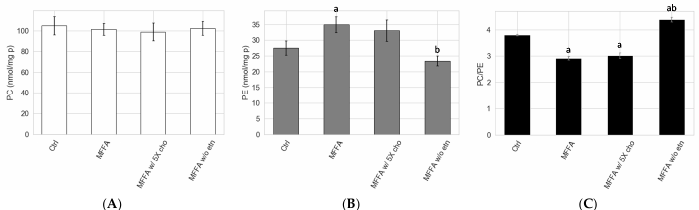
Figure 6. Impacts of altered supplies of key nutrients involved in phospholipid biosynthesis on MFFA-treated hepatocyte phospholipid and PC/PE. Isolated rat hepatocytes were treated without (Ctrl) or with 2 mM of MFFA in special DMEM media of which choline was increased to five times of the standard doses (i.e., 150 μM, MFFA w/5X cho), or had ethano- lamine removed completely (MFFA w/o etn) for 24 h before being harvested and lipid extraction. The cellular PC and PE profiles were subsequently determined by LC-MS lipidomic analysis ( A and B ), and PC/PE was calculated accordingly ( C ). Data shown as mean ± sem; a: p < 0.05 vs. Ctrl group; b: p < 0.05 vs. MFFA group, both determined by Mann–Whitney U test ( n = 5 for Ctrl, MFFA and MFFA w/o etn groups; n = 4 for MFFA w/5X cho group). Metabolites 2021 , 11 , x FOR PEER REVIEW